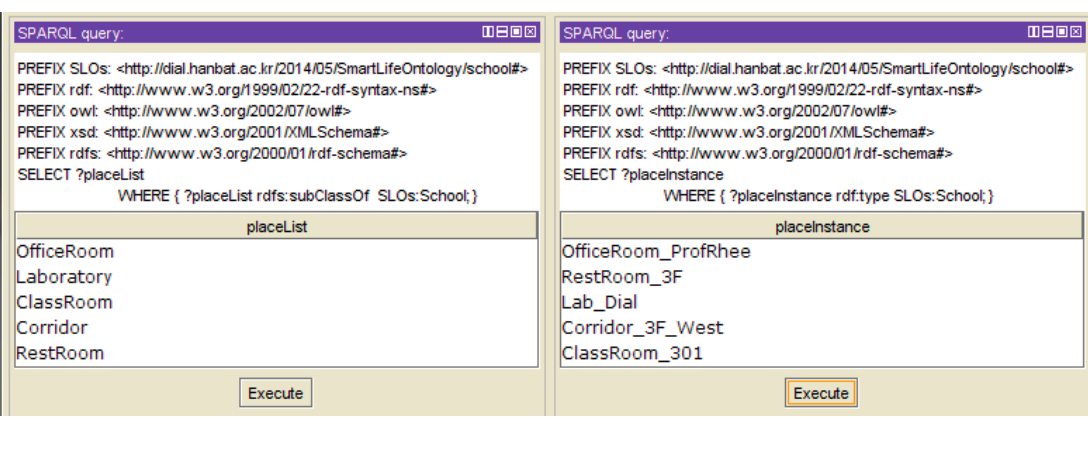
Figure 14. Examples of place query result